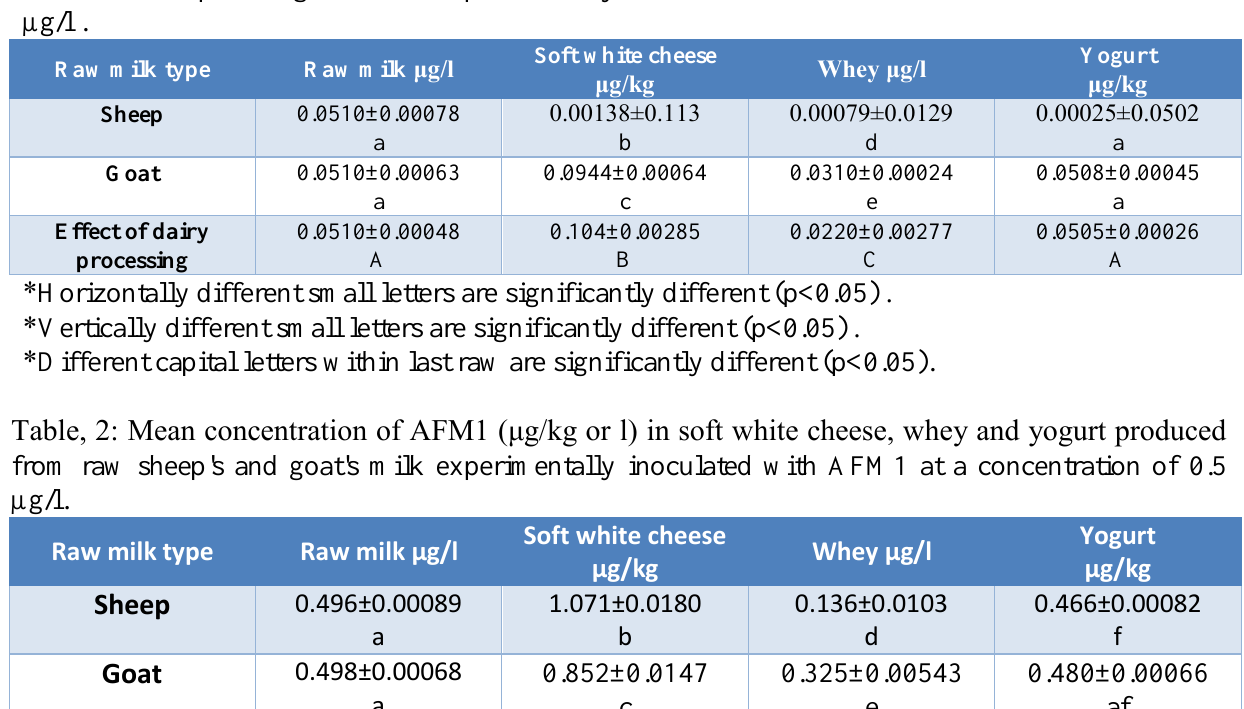
Table, 1: Mean concentration of AFM1 (μg/kg or l) in soft white cheese, whey and yogurt produced from raw sheep's and goat's milk experimentally inoculated with AFM1 at a concentration of 0.05 µg/l . Soft white cheese Raw milk type Raw milk μg/l Sheep